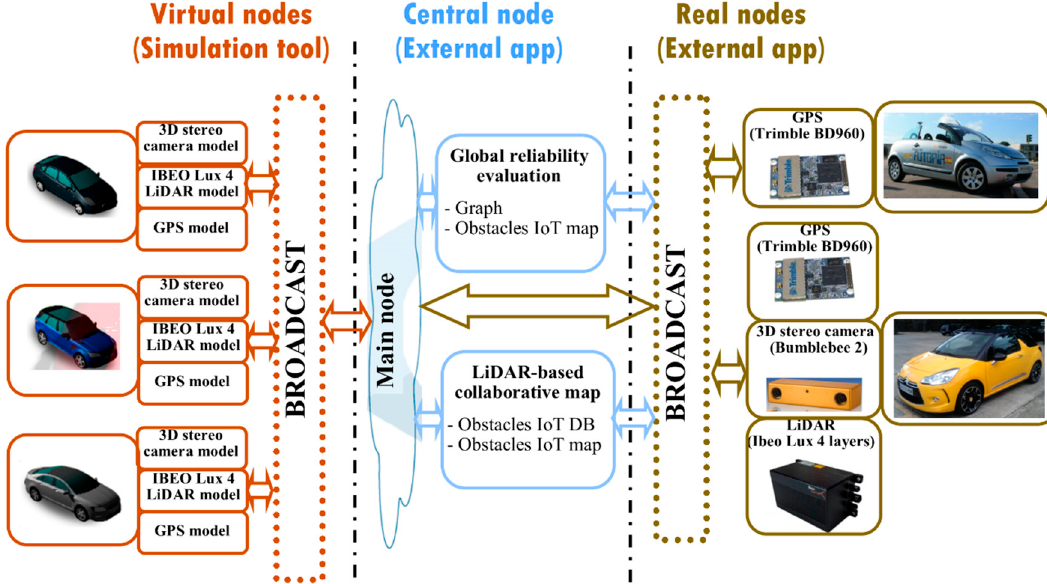
Figure 4. Detailed diagram of the implementation of the LiDAR-based collaborative map approached through a CPS-based co-simulation framework.